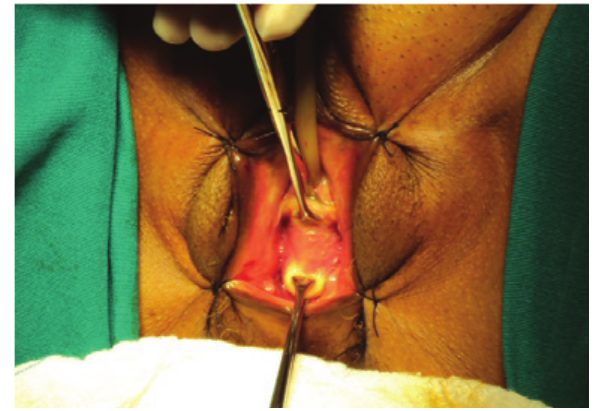
Figure 3 - Incision of mid urethra for introduction of sling.